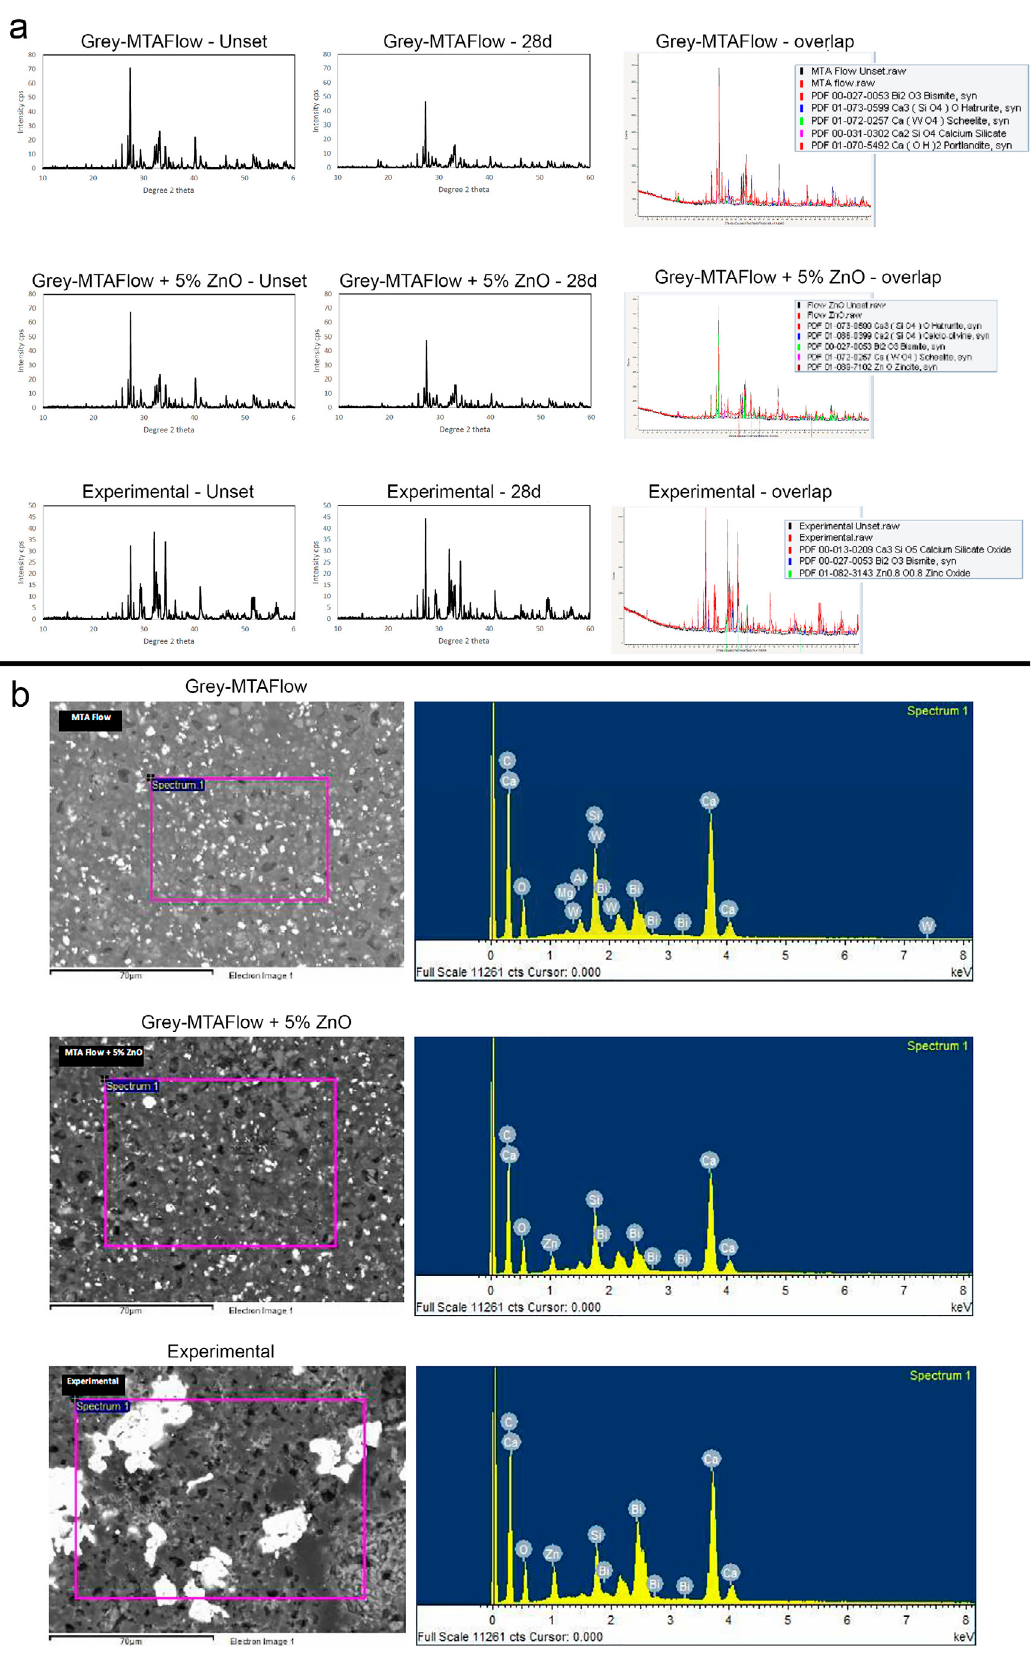
Figure 3- (a) X-ray diffraction plots of un-hydrated and hydrated cement and overlap diffraction. Calcium hydroxide (portlandite) was detected in hydrated Grey-MTAFlow cement and not observed in the other tested compositions. Scanning electron micrographs (SEM) and energy dispersive spectroscopy (EDS). (b) SEM micrographs and EDS plots of hydrated cement revealed particles of cement interposed by small particles of radiopacifier, with peaks detected. Experimental cement showed large particles of bismuth oxide, suggesting aggregation of this